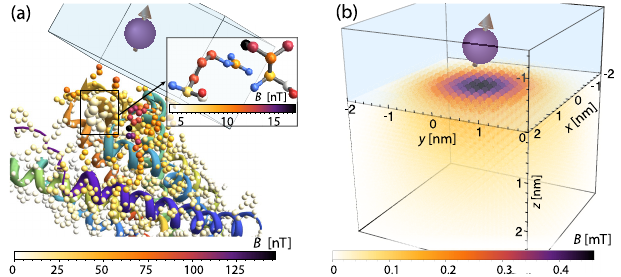
FIG. 1. (a) Nuclear spin imaging with a shallow NV center in diamond. A single NV spin (purple) at 1 – 2 nm from the diamond surface can sense single nuclear spins in a molecule (the chemokine receptor CXCR4 [29], ribbon diagram) anchored to the diamond. The magnetic field produced by individual 13 C (spheres with color scale given by B j ⊥ = γ ) is in the range of nT, e within reach of NV sensitivity. In the inset, we show the binding site of interest [atoms other than 13 C are blue (O) and red (N)]. (b) A shallow NV center (2 nm from the surface) creates a magnetic field gradient [ A ð ~r Þ = γ ] above the [111] surface of the n diamond. Note the azimuthal symmetry of the field, which causes degeneracy of the frequency shift at many spatial